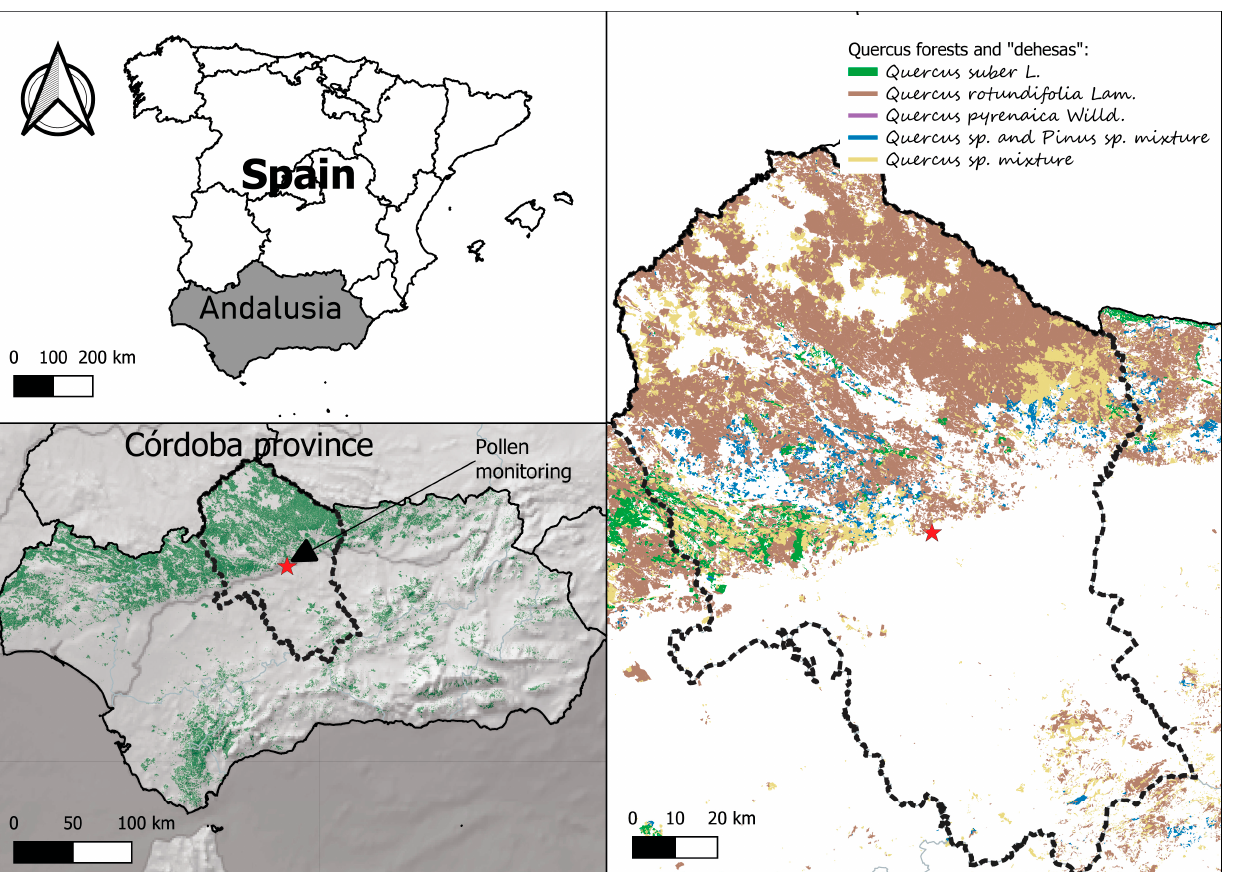
Figure 1. Study area and location of the pollen monitoring station in Cordoba city (37°53 ′ 00 ″ N 4°46 ′ 00 ″ W) are indicated in relation to the Quercus landscape distribution in the Andalusia Region and Cordoba province (right picture). Source: Plan Forestal Andaluz, 2018 [19].